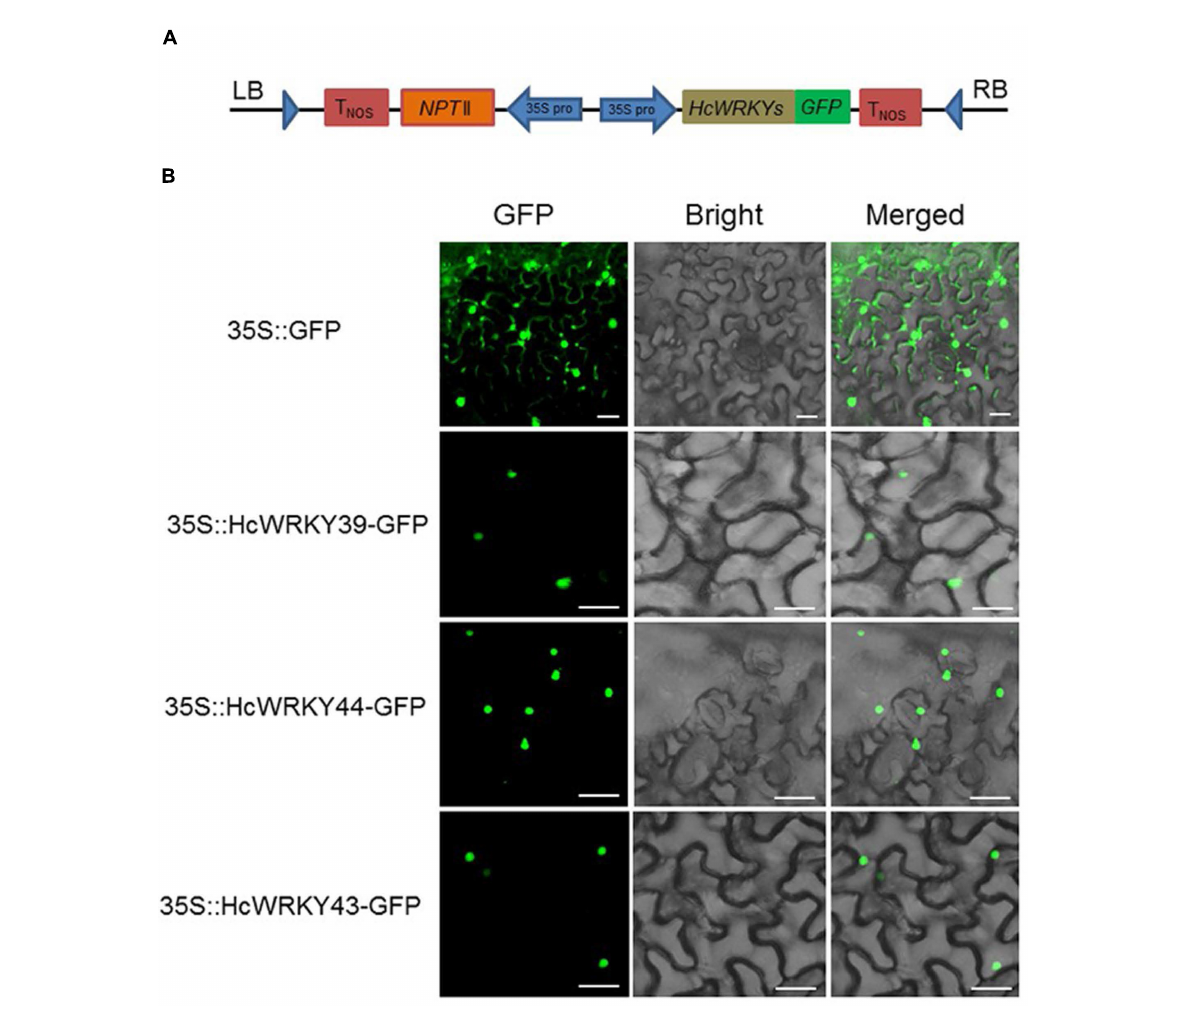
FIGURE5 Subcellular localization of three HcWRKY proteins from each group. (A) A schematic representation of 35S:HcWRKYs-GFP fusion construct and 35S:GFP construct. The coding sequences of HcWRKY39/44/43 genes were fused with GFP expression vector. (B) Subcellular localization analysis was performed using the transient transformation in leaves of N. benthamiana , and GFP signals were checked by a confocal laser scanning